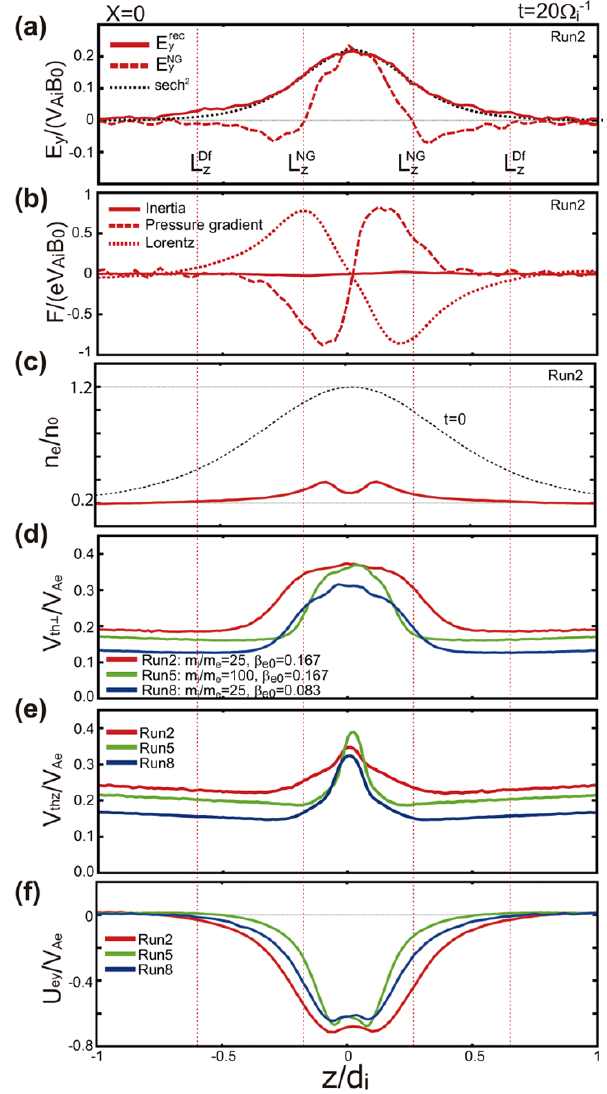
Figure 4. Cuts from the white dashed line in Fig. 2c of E rec y (cid:16) 1 (cid:17) ∂P e zz m e U e z (z) 2 and E NG y (a) , ∂ , − 1 and − eU e y B x (b) n e ∂z ∂z 2 and n e (c) for Run 2, and V th ⊥ = p (P e yy + P e zz )/ 2 n (d) , V th z = √ e P e zz /n e (e) and U e y (f) normalized by V Ae for Runs 2 (red), 5 (green) and 8 (blue). Vertical lines show the location of | z | = L Df z and L NG z for Run 2. The black dotted line in (c) shows the initial density profile.